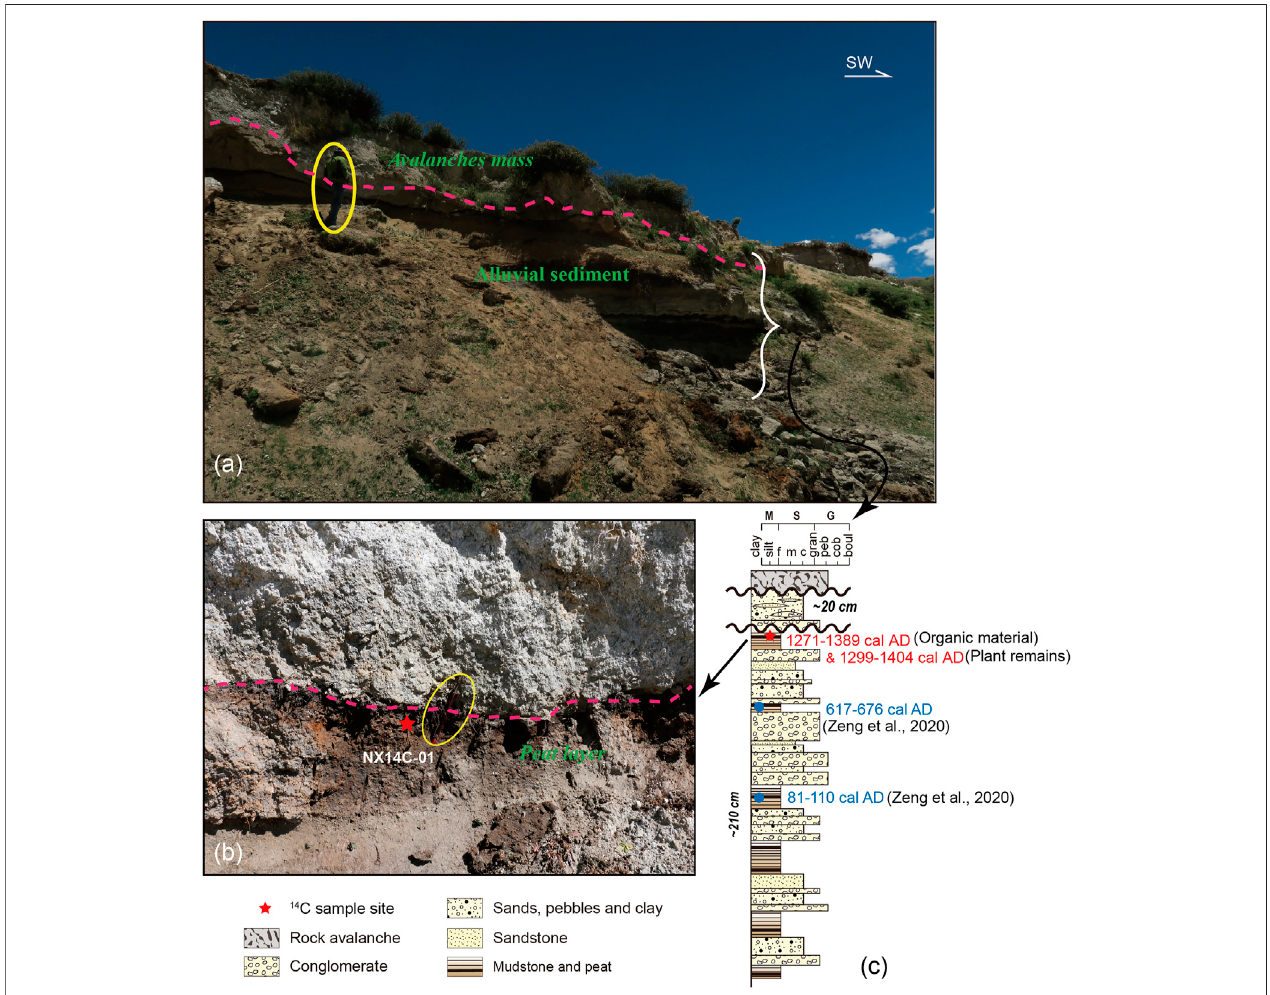
FIGURE 4 | (A,B) The 14 C sample was collected from the peat layer underneath the NCRA to constrain the maximum age of the second event in the NCRA. (C) Therearenorockavalanchesedimentsinthestratigraphicsection before1,271 – 1,389 calAD.Thus,theearlyrock avalancheeventoccurredinregion2 (Figure3) with anageof425 – 565 calADanddidnotreachthesiteofsampleNX14C-01.Thetermsforsedimentaryrocksandgrainsizes:mud(M);sand(S), fi ne(f),coarse(c),medium (m); gravel (G), granule (gran), pebble (peb), cobble (cob), boulder (boul).